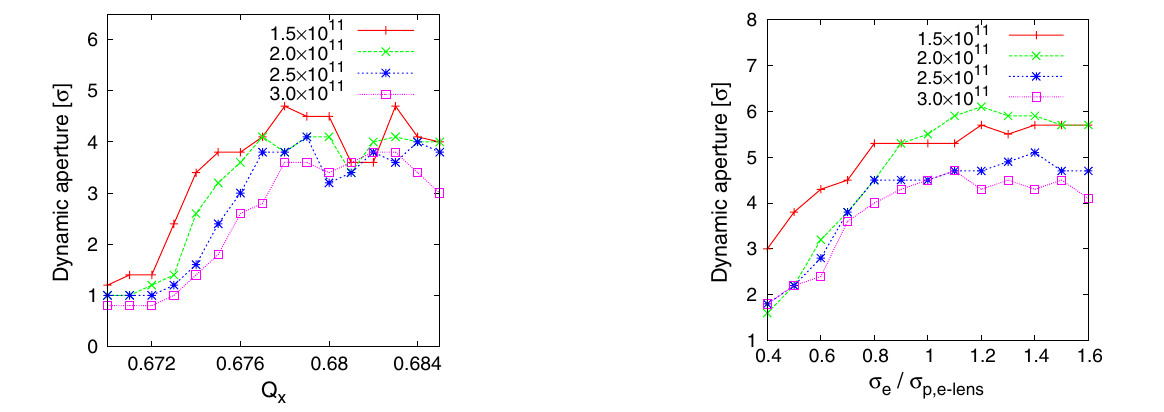
FIG. 12. Dynamic apertures of full head-on beam-beam com- pensation in the scan of proton working point. The horizontal axis is the fractional horizontal zero-amplitude tune. The frac- tional vertical zero-amplitude tune is always 0.01 higher than the horizontal one.